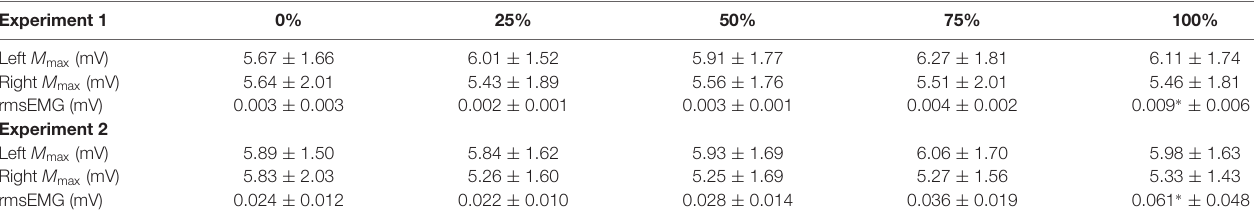
TABLE 1 | Maximal compound waves from the right and left rectus femoris (RF), and pre-stimulus rmsEMG values recorded from the right RF, for both experiments (Mean ± SD). Experiment